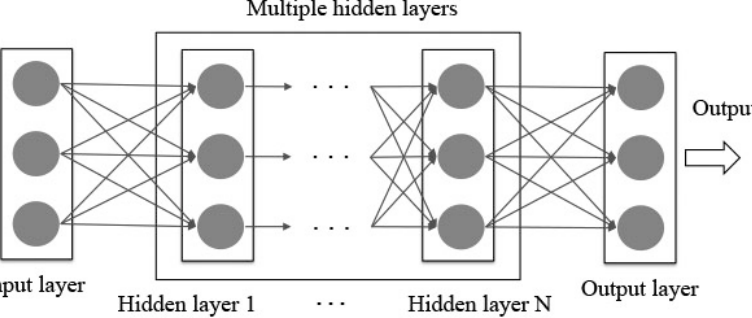
Figure 18. Deep learning consisting of input, multiple hidden neural network layers, and output layer.